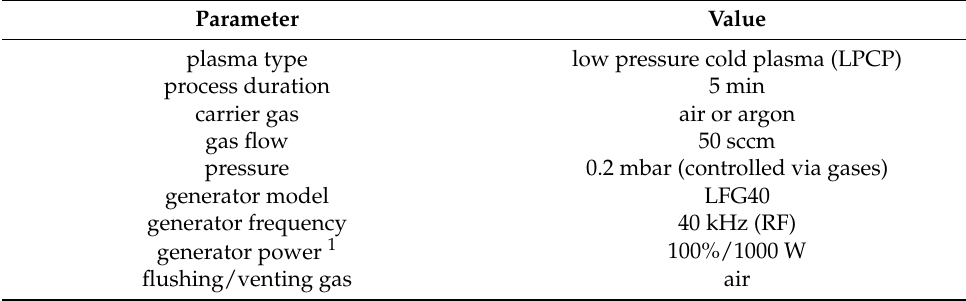
Table 1. Plasma process parameters for the activation of the glass supports.